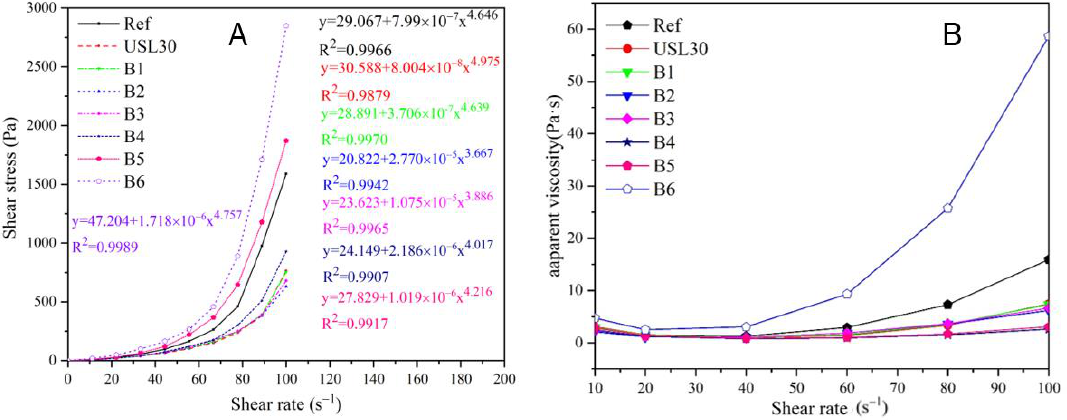
Figure 5. Rheology curves of the cement slurry with different USL or LS content. ( A ) shear stress ( B ) apparent